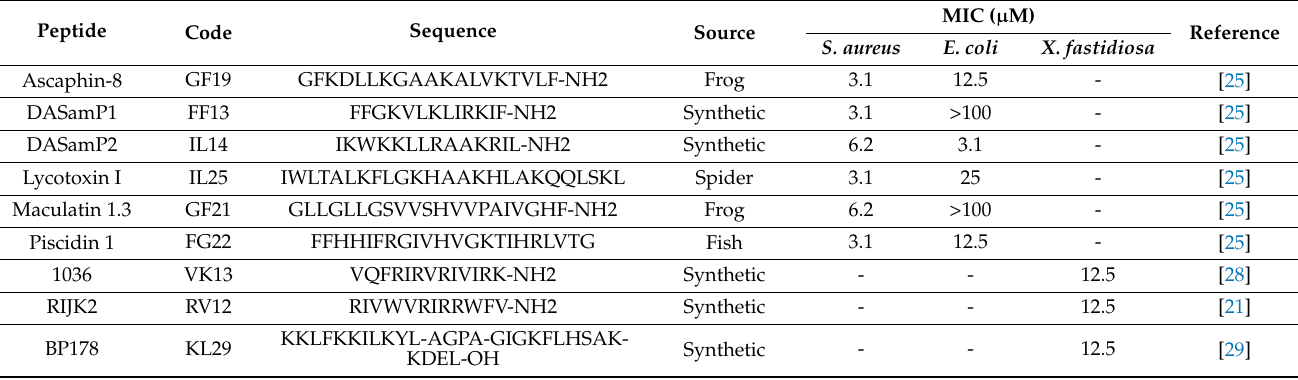
Table 1. List of AMPs used for studying their effect on Xylella fastidiosa